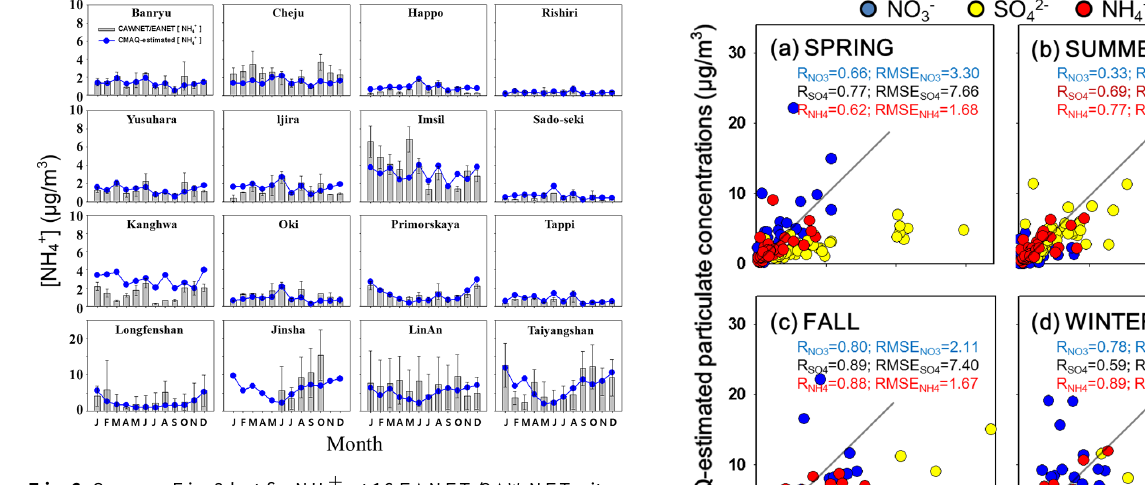
Fig. 6. Same as Fig. 3 but for NH +